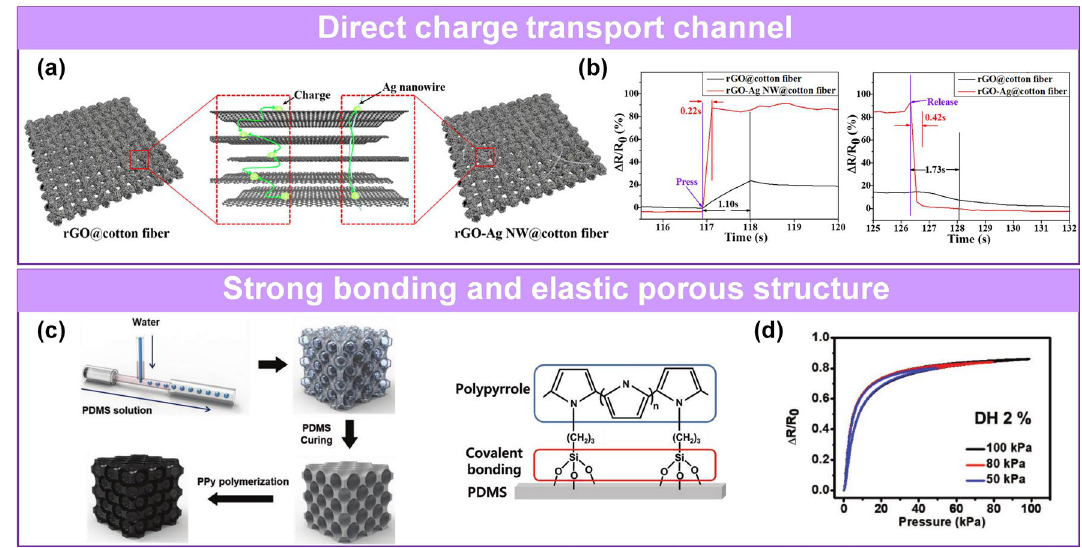
Fig. 10 Pressure sensors with fast response and low hysteresis. a The mechanism diagram of charge transport and b response time comparison of rGO@cotton fiber and rGO-Ag NWs@cotton fiber [85]. Copyright (2018) Elsevier. c Fabrication process of and interaction between PPy and PDMS. d Hysteresis loops of sensor [84]. Copyright (2019)